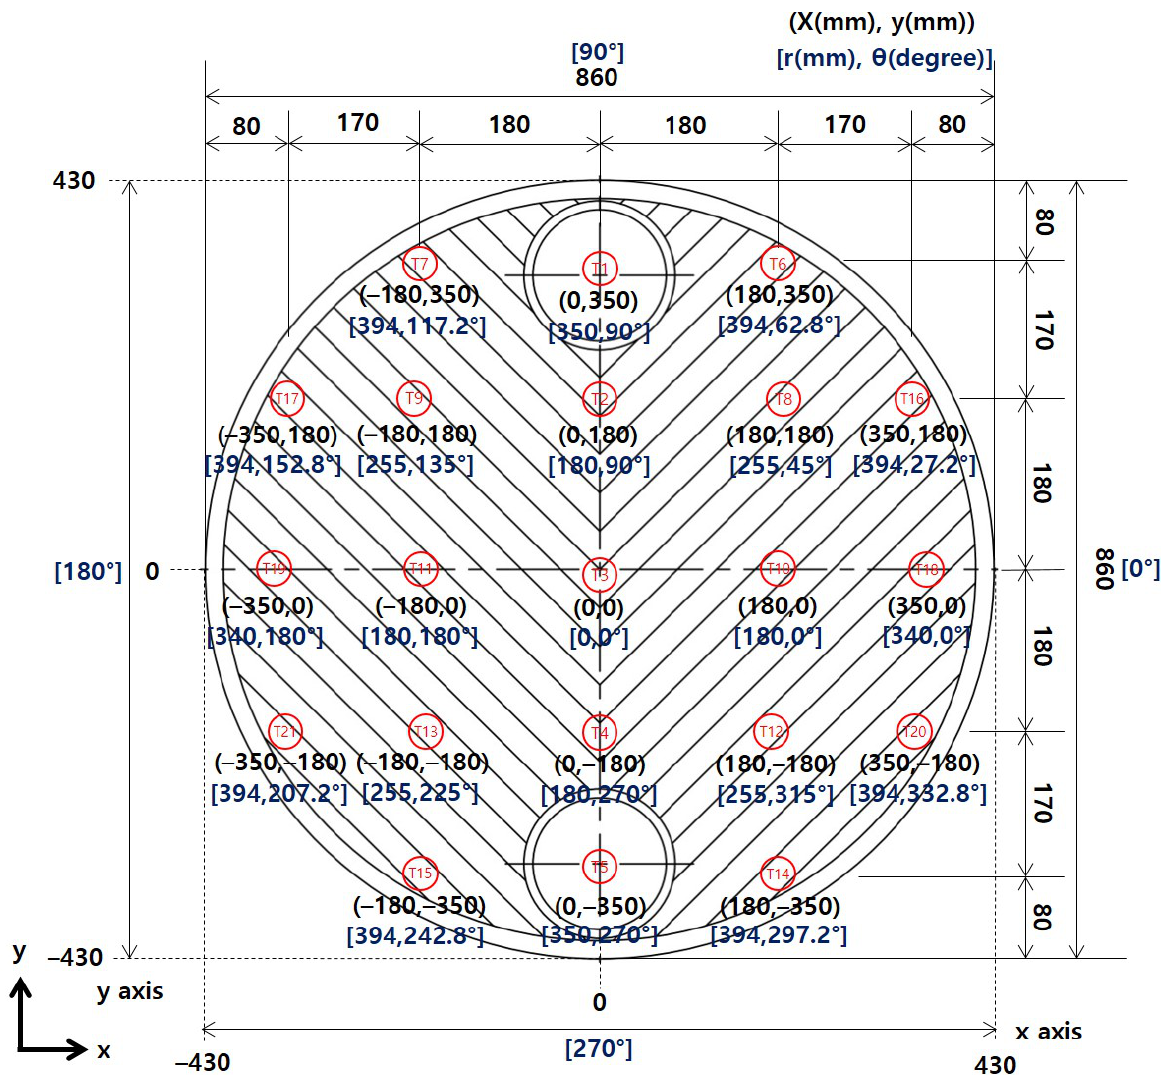
Figure 4. Positions of temperature sensors on the circular plate.